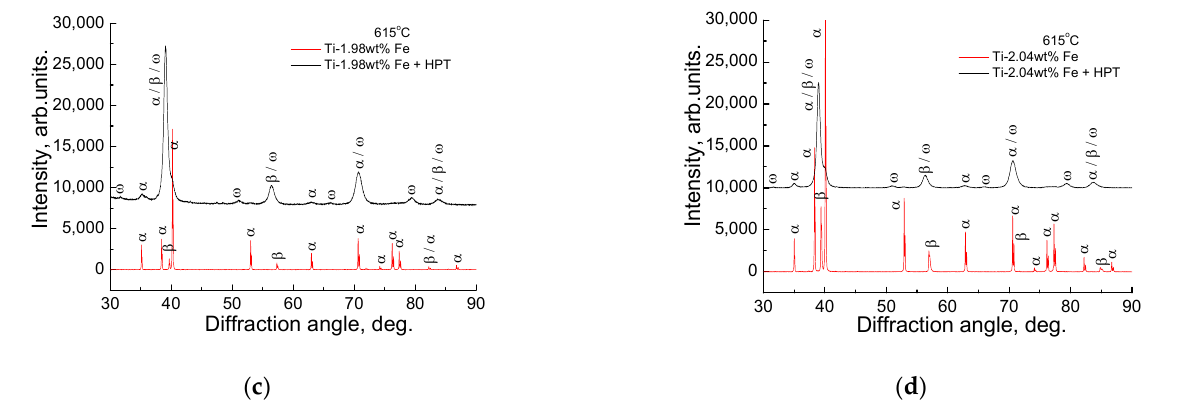
Figure 1. XRD patterns for the Ti–2.36 wt.% Fe ( a ), Ti–3.93 wt.% Fe ( b ), Ti–1.98 wt.% Fe ( c ) and Ti–2.04 wt.% Fe; and ( d ) alloys annealed at 470 °C ( a , b ) and 615 °C ( c , d ). The bottom curves (red) are for the annealed samples before HPT, the top curves (black) are for the annealed samples after HPT.